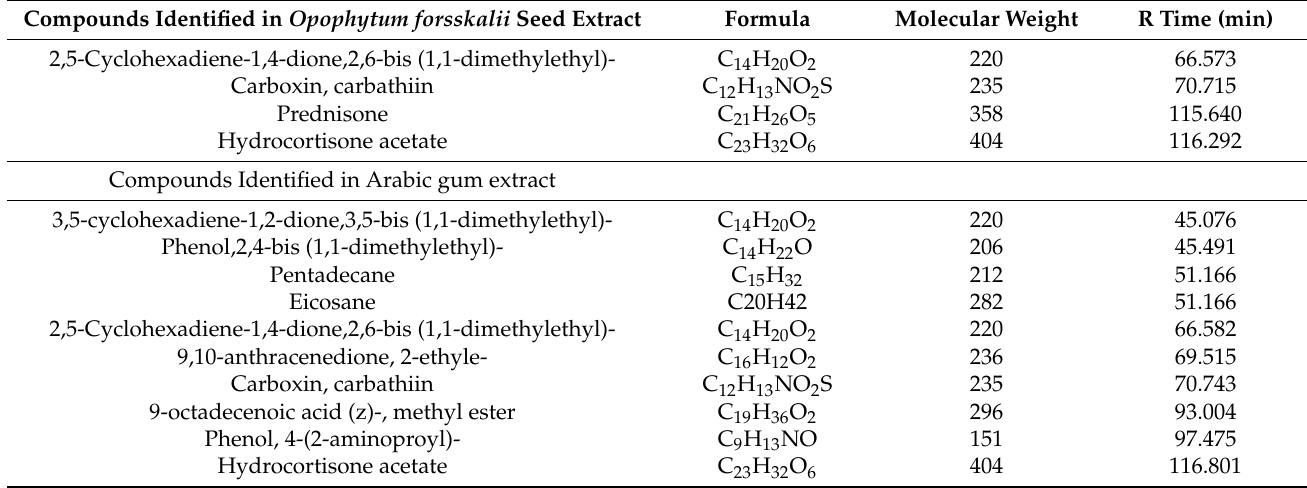
Table 1. GC-MS analysis results of Opophytum forsskalii and arabic Gum extracts.